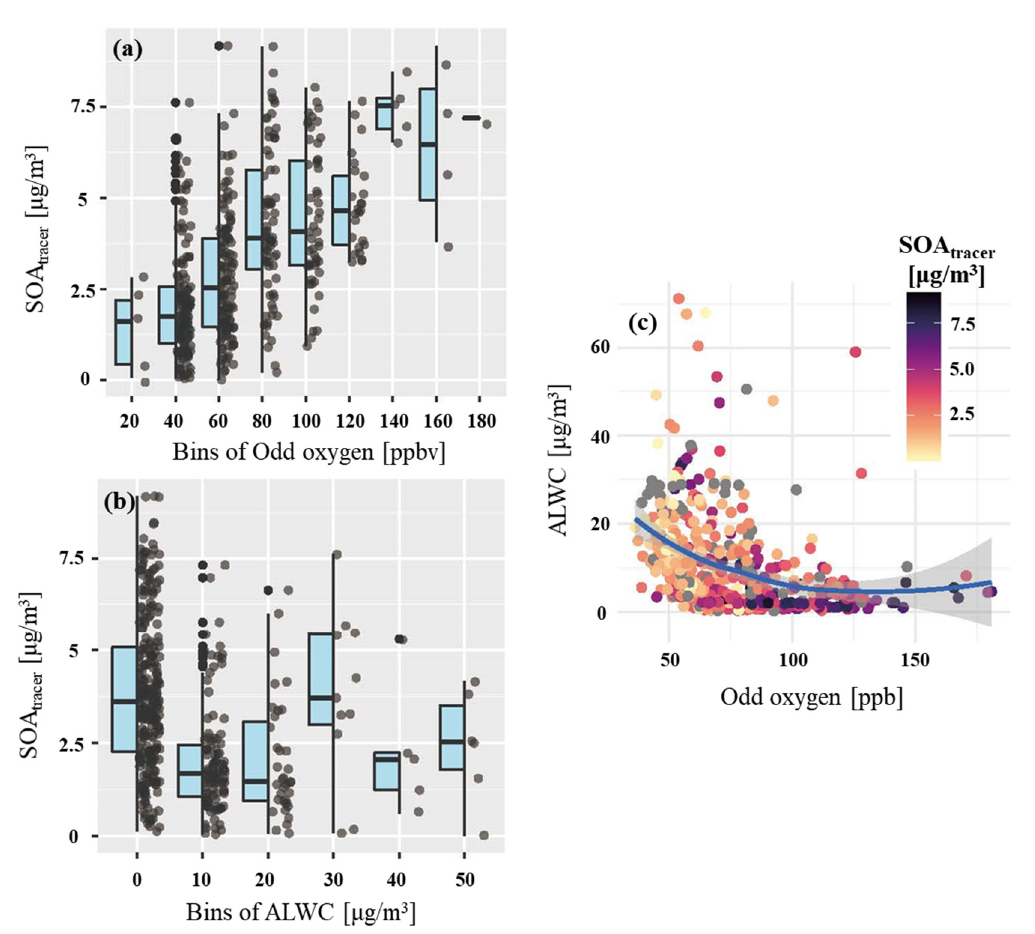
Figure 5. The SOA tracer as a function of ( a ) Odd oxygen (O x , bins of 20 ppbv) and ( b ) aerosol liquid water contents (ALWC, bins of 10 μ g/m 3 ). Box: 25% and 75% percentile. Whisker: 10% and 90% percentile. ( c ) Scatterplot of ALWC and Odd oxygen.